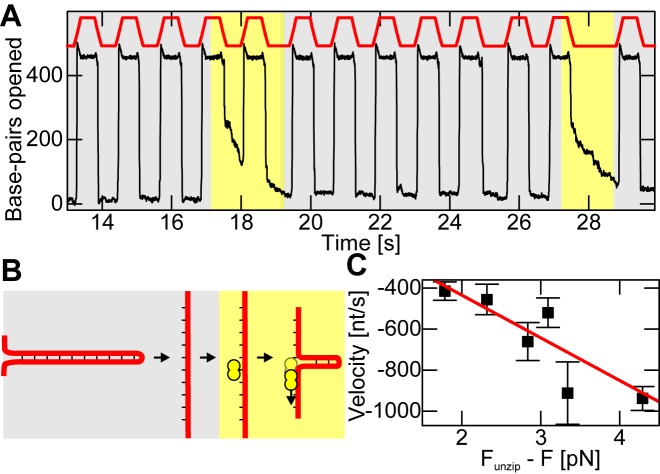
Sliding of RPA along ssDNA upon dsDNA rezipping. (A) Repetitive opening and closing the hairpin by alternating the applied force between 22.5 and 15.5 pN (as indicated in red) at a low hRPA concentration of 150 pM (in 1 mM Mg2+ buffer). For the majority of the unzipping cycles (gray background) the closing of the hairpin is unperturbed. Approximately once in 10 cycles, a continuous slower closing is however observed (pale yellow background) that is attributed to RPA sliding. (B) Cartoon illustrating the observed behavior according to the background colors used in A. In case of sliding events, a single hRPA heterotrimer is thought to bind to the exposed ssDNA after hairpin opening. When the force is reduced, the closing hairpin pushes the hRPA along the ssDNA. (C) Mean sliding velocity (black squares, error bars indicate standard errors) as a function of the pushing force applied by the hairpin (difference between characteristic unzipping force and the applied force). A linear fit describes the observed trend well (R2 = 0.86), with the intersection of the velocity axis at −18.23 nt/s for zero force. Furthermore, the slope of this fit can be used to calculate a friction coefficient, as the velocity is expected to vary with the force as given by F = ζ · \documentclass[12pt]{minimal}
\usepackage{amsmath}
\usepackage{wasysym}
\usepackage{amsfonts}
\usepackage{amssymb}
\usepackage{amsbsy}
\usepackage{upgreek}
\usepackage{mathrsfs}
\setlength{\oddsidemargin}{-69pt}
\begin{document}
}{}$v$\end{document}, for which we find a value of ζ = 0.005 ± 0.0009 pN·nt−1 ·s.